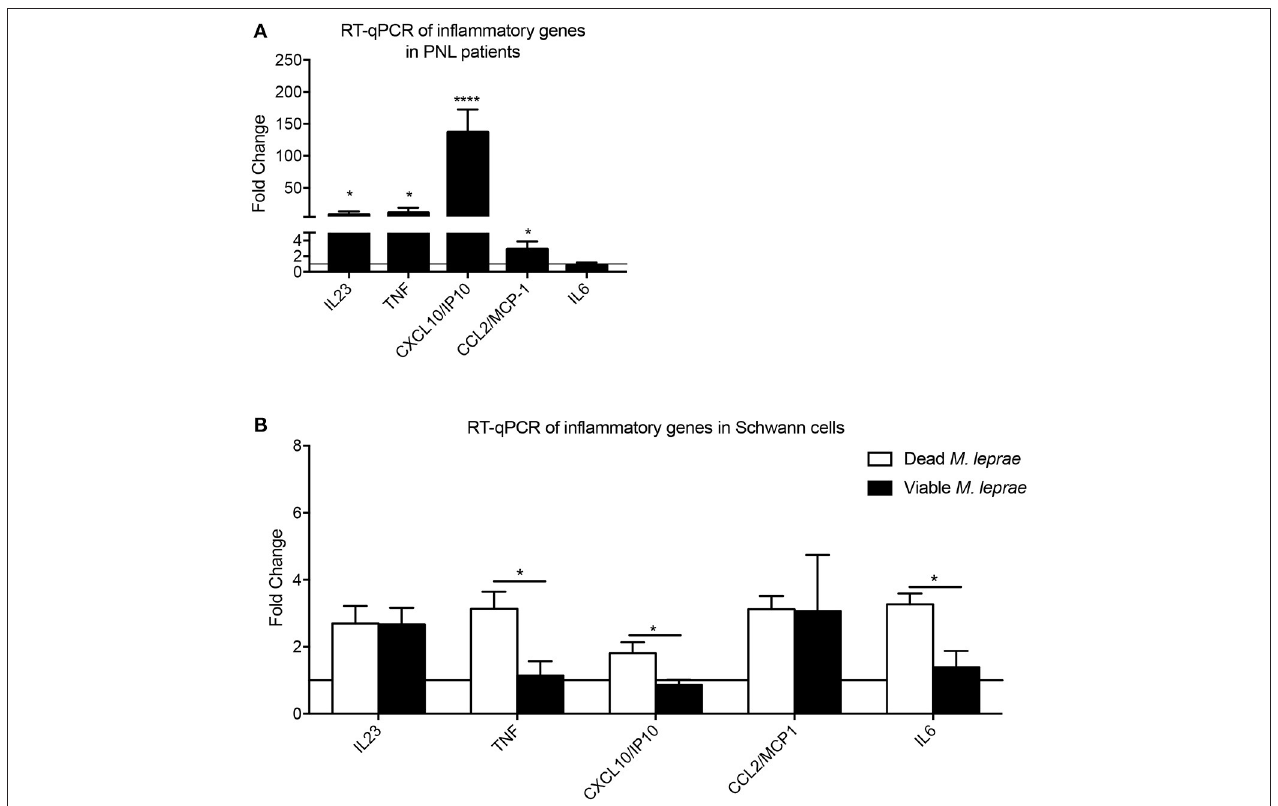
FIGURE 3 | Analysis of inflammatory network in leprosy infection. Fold-change measurement of inflammatory cytokines/chemokines mRNA transcripts in human nerve biopsies from leprosy ( A , black bars) and non-leprosy patients ( A , horizontal line) and in human Schwann cells (B) infected with dead M. leprae (white bars) and viable M. leprae (black bars); results are presented as mean ± SD from three to eight normalized independent biological replicates; * p < 0.05, **** p <